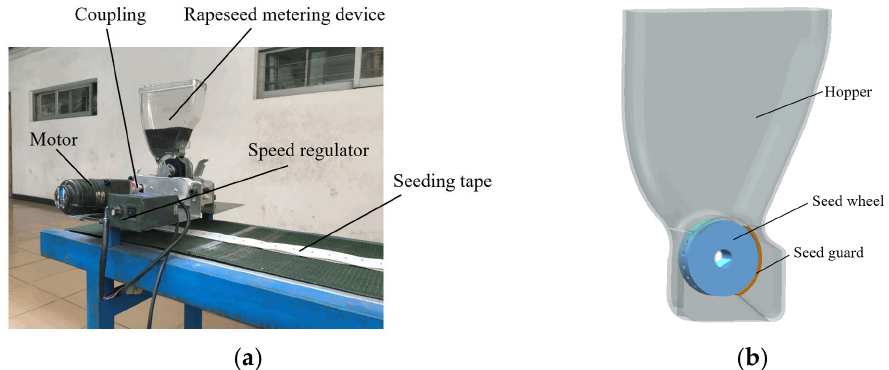
Figure 7. The metering device for validation tests. ( a ) Bench of the rapeseed metering device; ( b ) The simulation model.